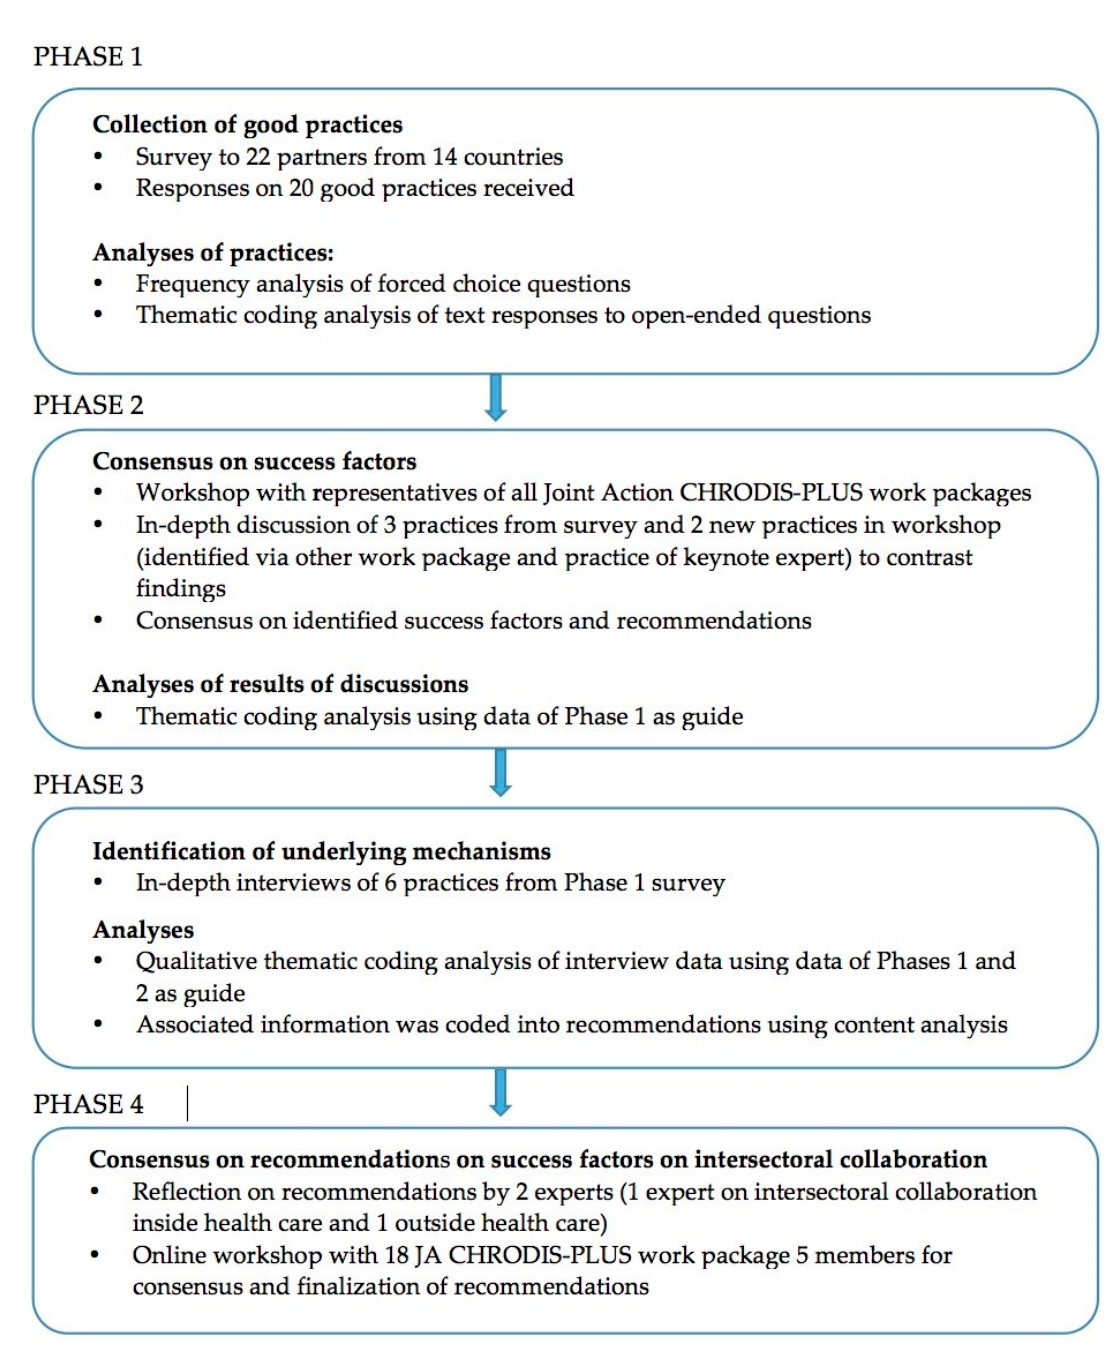
Figure 1. Design of the study: presentation of the data collection and analyses to identify success factors of good practices.